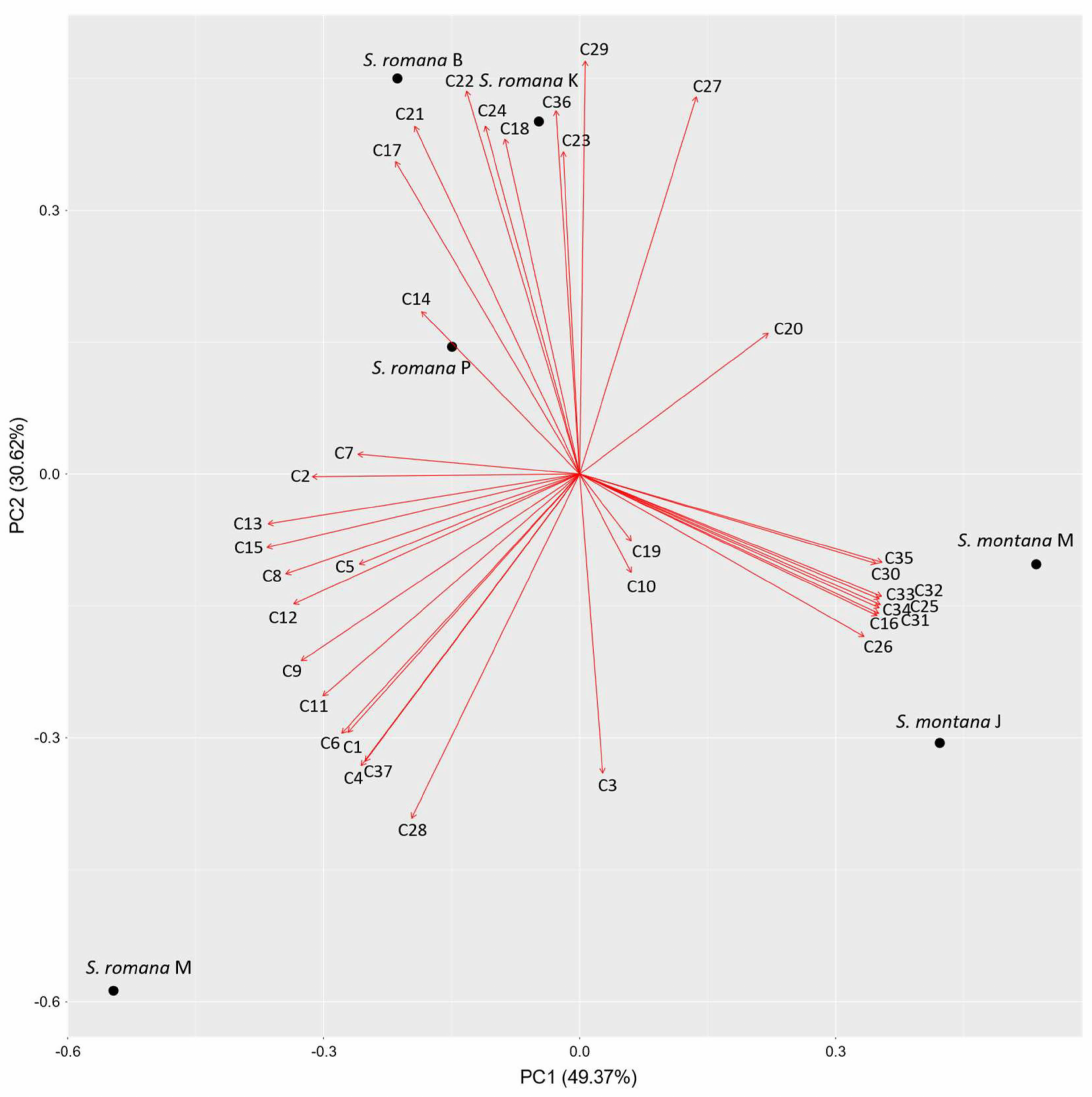
Figure 3. Biplot obtained by principal component analysis of VOCs composition of investigated populations of S. romana and S. montana , based on major components with average percentages ≥ 1% in at least one of the samples, detected with DVB/CAR/PDMS